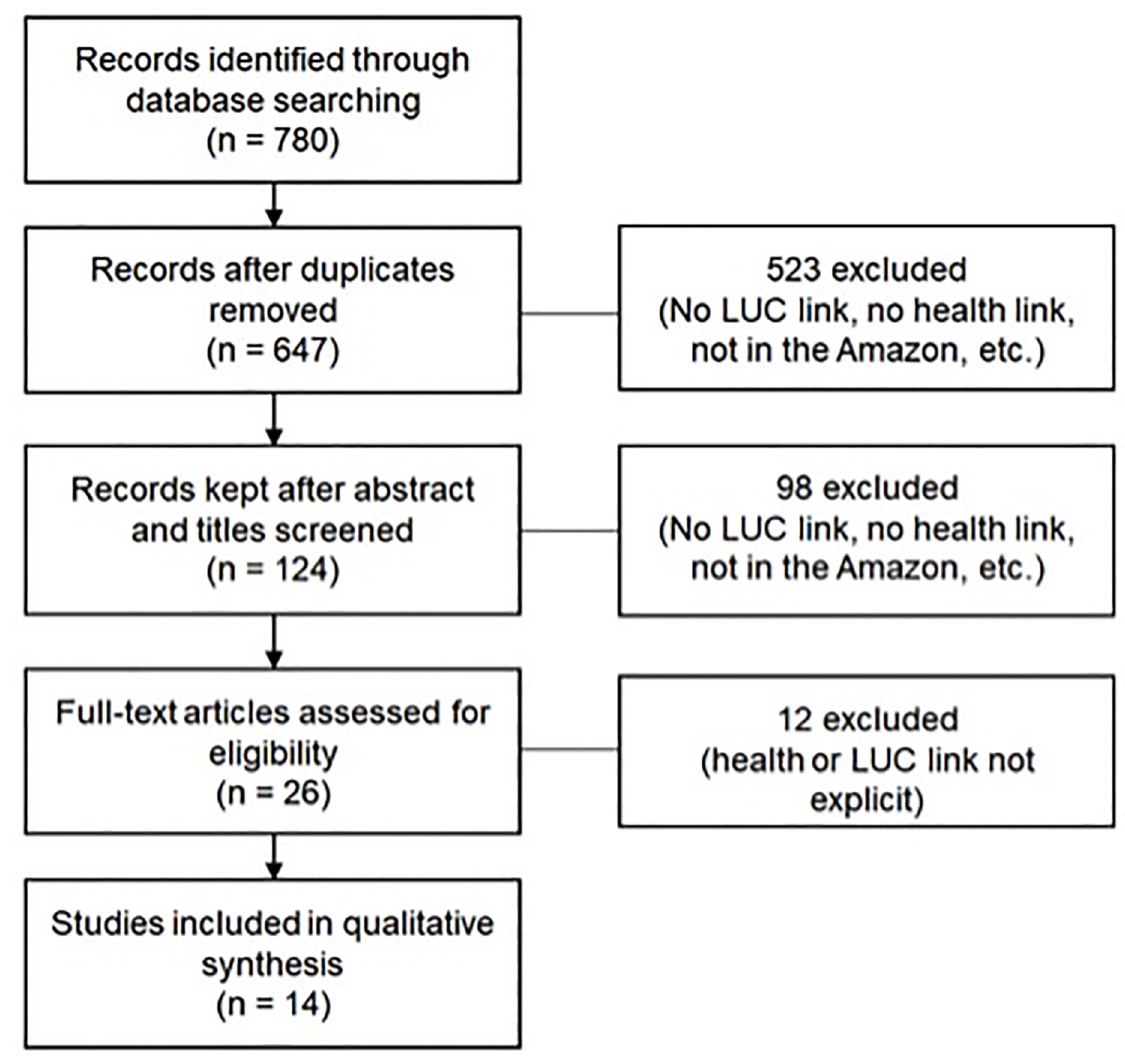
Fig 1. Flowchart. Flowchart of study selection